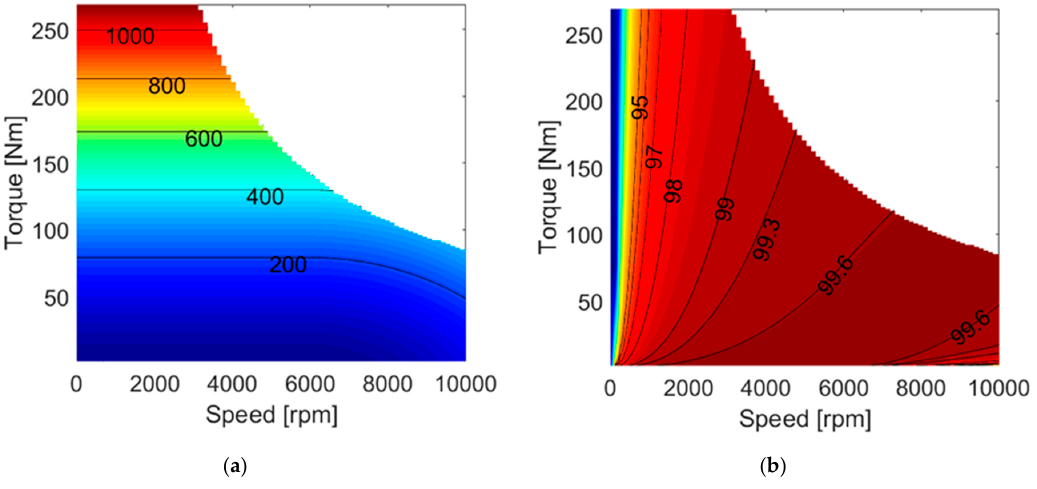
Figure 7. ( a ) SiC inverter losses [W] and ( b ) efficiency [%].